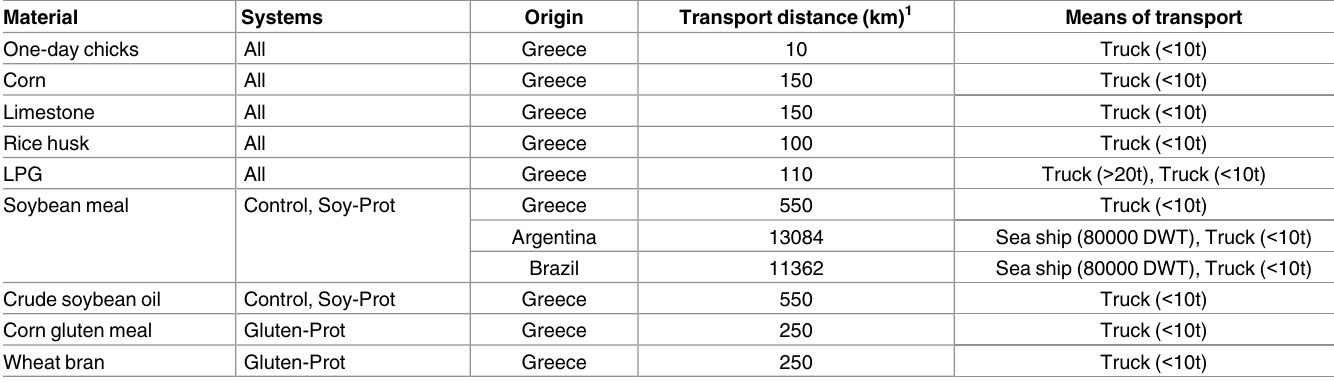
Table 3. Transport distances to the broiler